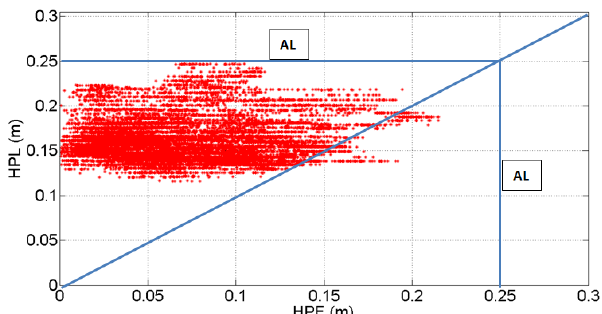
Figure 7. HPE and HPL correlation for in automatic docking phase (after the convergence of the real-time IGS-RTS PPP- based GPS solution to the favorable performance – after 2515